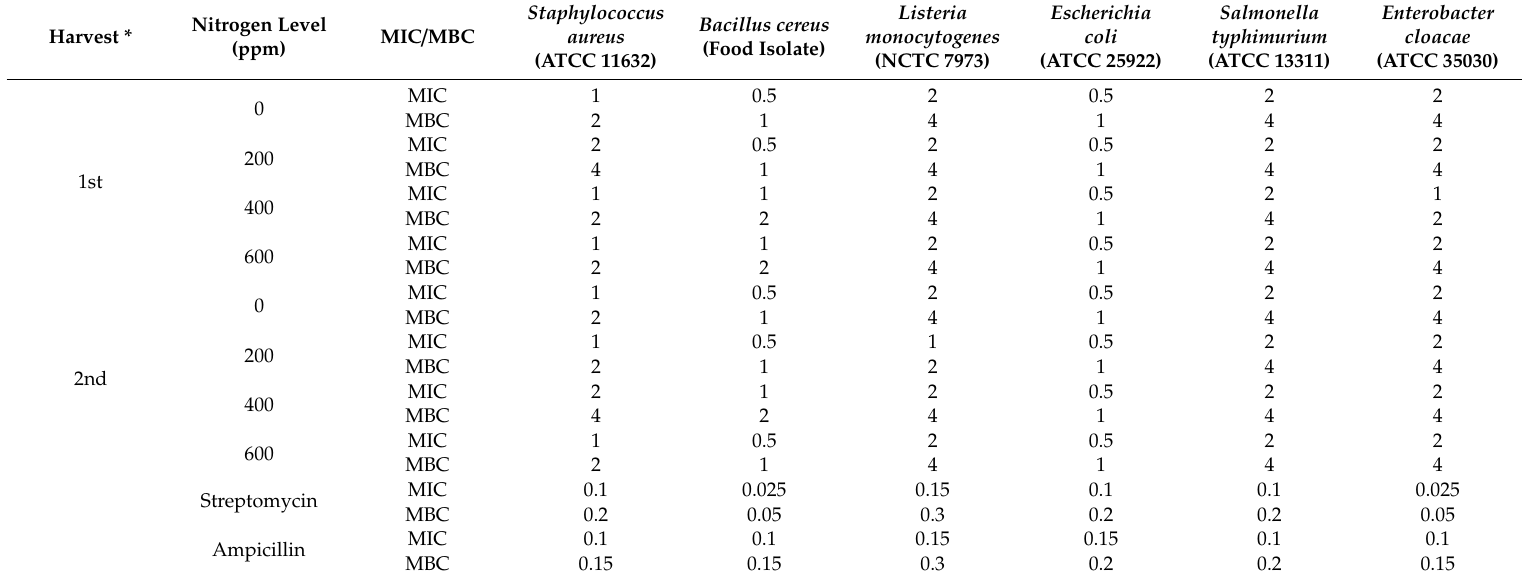
Table 11. Antibacterial activity (MIC and MBC in mg / mL) of Centaurea raphanina subsp. mixta plants grown in 2 L pots under greenhouse conditions, in relation